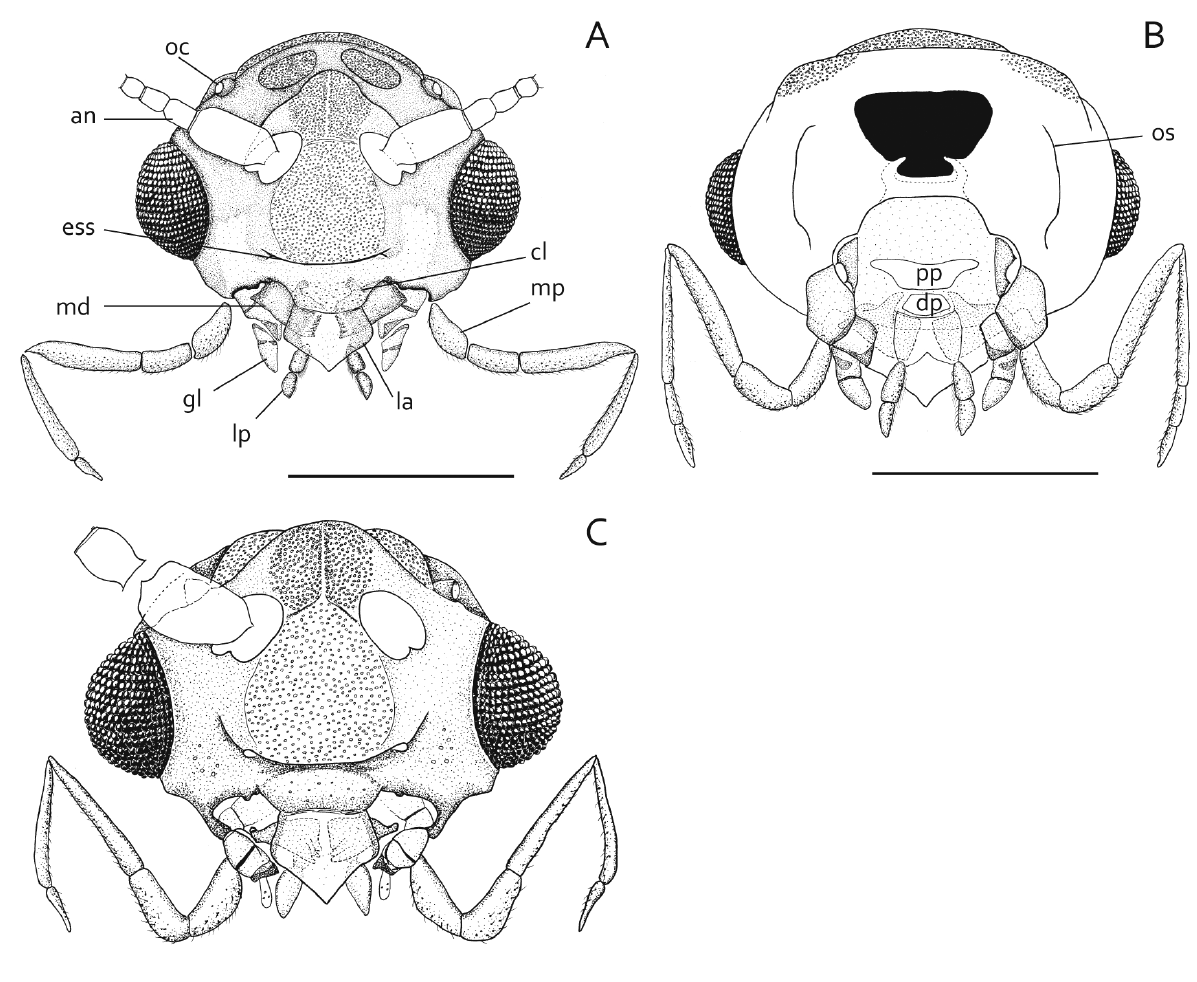
Figure 2. Adult heads of Melinopteryx and Issikiomartyria . A: Melinopteryx bilobata sp. n., frontal view; B: ditto, posterior view; C: Issikiomartyria hyperborea sp. n., frontal view. Abbreviations: an = antenna; cl = clypeus; dp = distal prelabium; ess = episto - mal sulcus; gl = galea; la = labium; lp = labial palp; md = mandible; mp = mandibular palp; oc = ocellus; os = occipital sulcus; pp = proximal prelabium. Scale bars: 0.5